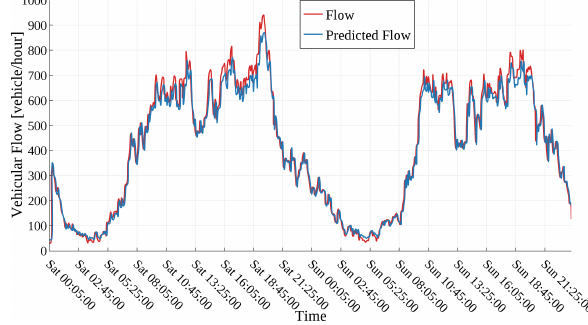
Figure 8. Predicted traffic flow vs actual traffic flow for CGA intersection VF northbound dataset consisting of weekends (Saturday and Sunday) using pre-processing scheme B (Moving average)